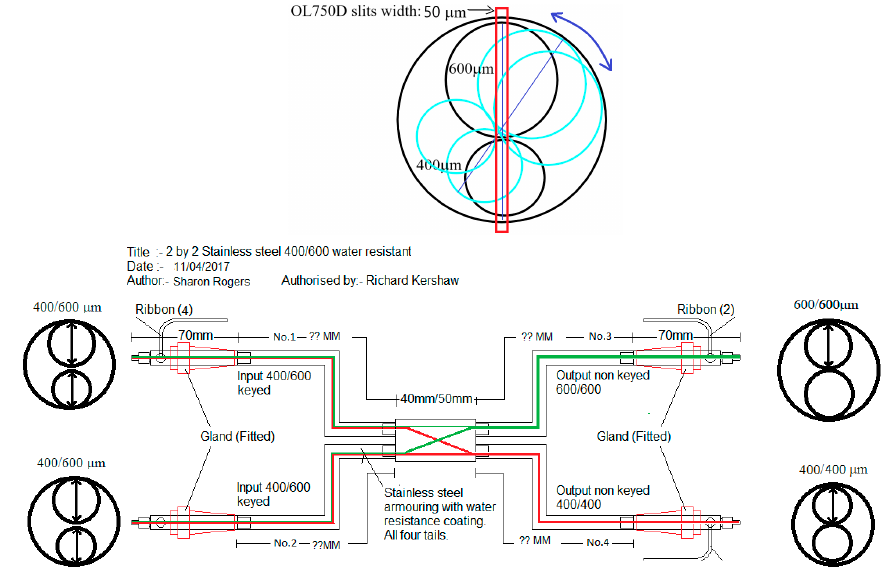
Figure 2. Schematic of the Piccolo system double bifurcated fore optic cable assembly showing the fibre core configuration. Misalignment of the fibre core with the spectrometer slit could lead to signal attenuation, and input geometry errors lead to geometry errors.